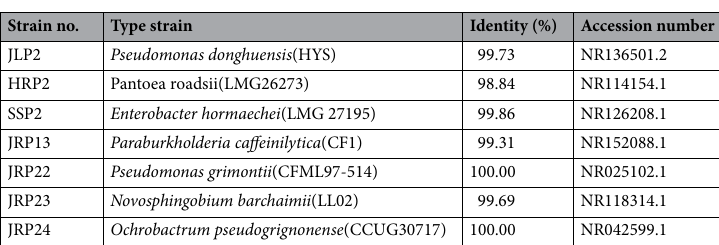
Table 4. Identification of PSB based on their 16S rRNA gene sequences.